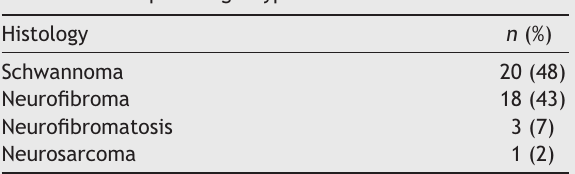
Histopathologic